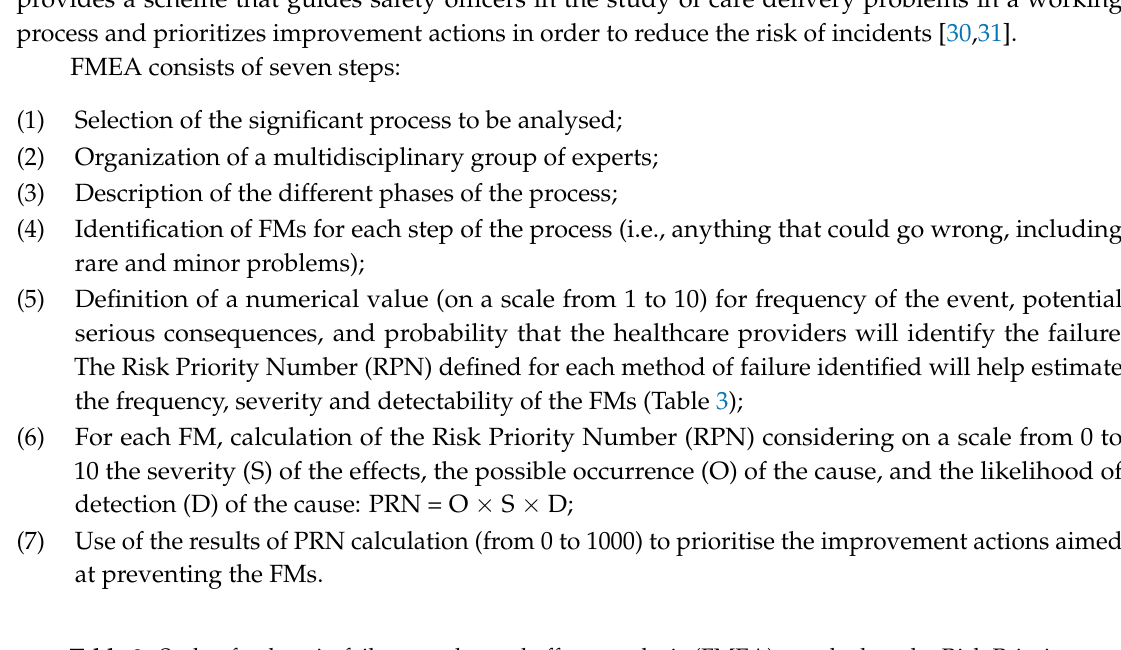
Table 3. Scale of values in failure modes and effects analysis (FMEA) to calculate the Risk Priority Number